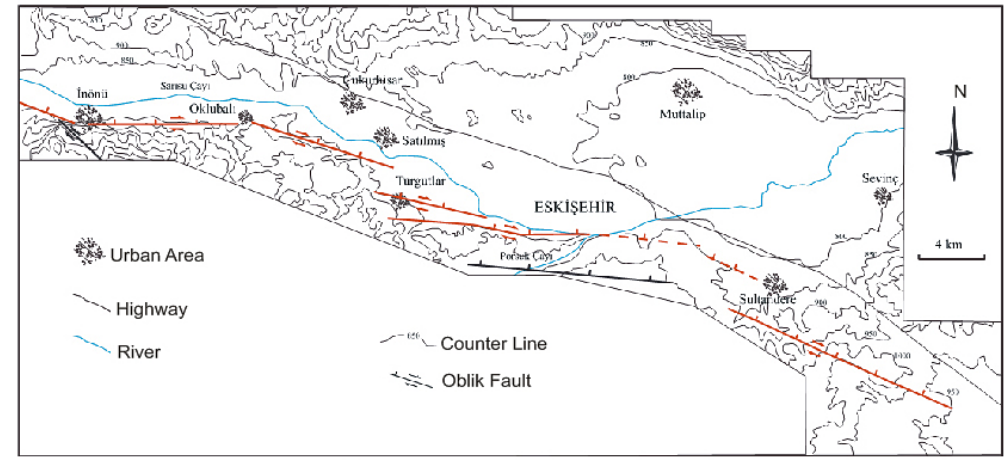
Figure 4. Tectonic map of Eski¸sehir (Altunel and Barka, 1998).